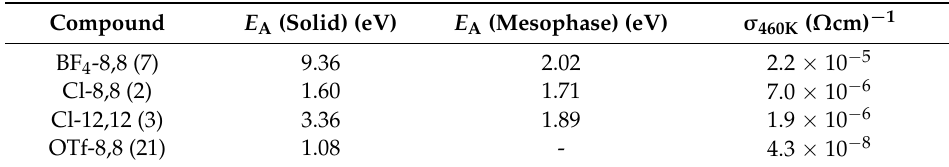
Table 4. Activation energies for compounds BF 4 -8,8 (7), Cl-8,8 (2), Cl-12,12 (3) and OTf-8,8 (21) in the solid state and in the mesophase. Conductivity values measured at 460 K.